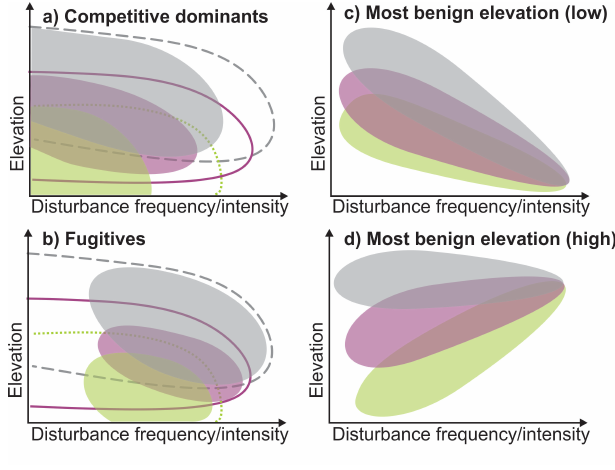
Fig. 4 . Schematic illustration of vegetation elevation zones determined by an elevation-dependent temperature gradient and influenced by a range of disturbance frequencies or intensities (for explanation see Figs. 2 and 3). The behavior of species and communities will depend on whether the species involved are competitive dominants relative to the other species present, persist at some location on the gradient without disturbance (a), or are fugitives that require disturbance to persist anywhere (b). The dotted lines show the boundary of the fundamental niche and where species might be seen to occur; the colored patches show where species can sustain themselves in the presence of other community members. Species may occur outside these boundaries as nonviable sink populations or perhaps because of positive interactions among species. In some situations the cold of high elevation may constrain plant growth suggesting that increasing disturbance will lead to most species having greater resilience to disturbance at lower elevations (c). However, where temperatures are sufficiently high to constrain growth, increasing disturbance will lead to most species having greater resilience to disturbance at higher elevations (d). Again, I highlight the artificial nature of presenting disturbance on a single axis, and for an entire gradient. In reality, we can modify many aspects of disturbance and decide whether such changes are uniform or locally